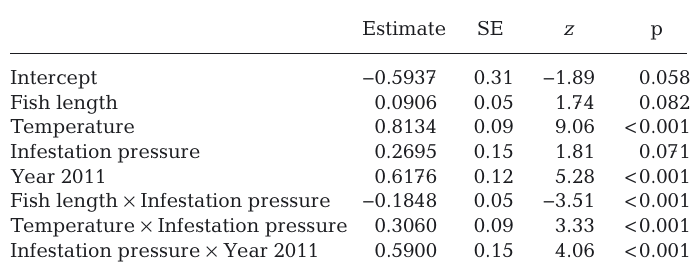
Table 1. Summary from the Bernoulli generalized linear mixed model explaining the probability of presence of attached lice (measured as